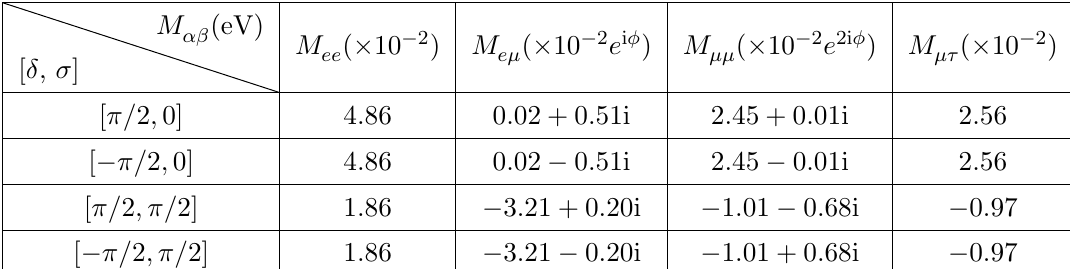
Table 2 . The possible values of M